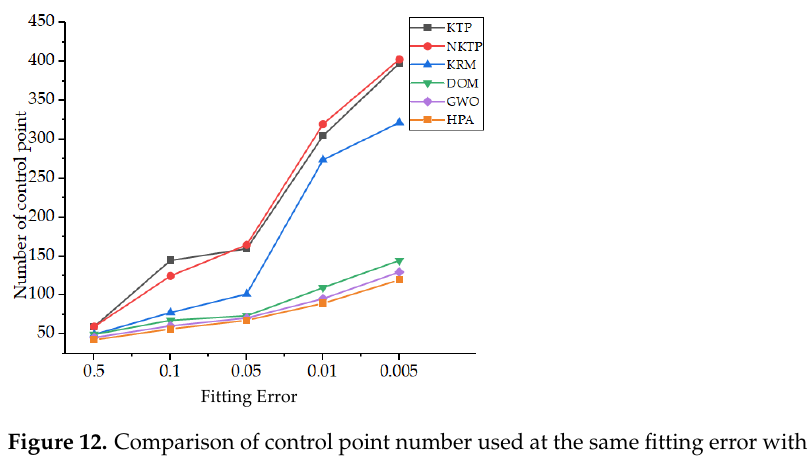
Figure 11. Comparing ( a ) the face data points and the fitting results of ( b ) DOM and ( c ) HPA especially at 1–3 marked.